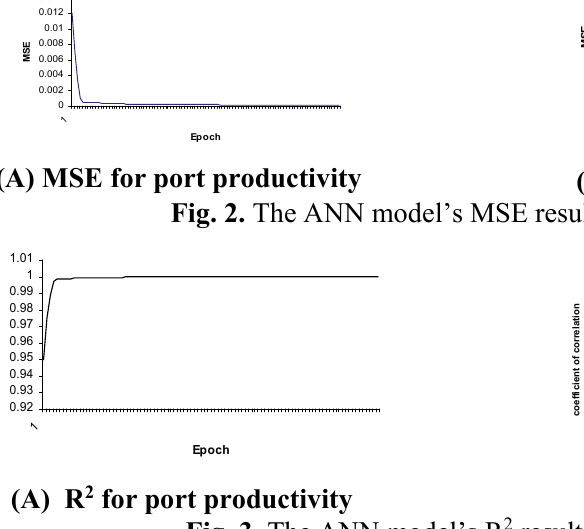
Fig. 3. The ANN model’s R 2 results during training